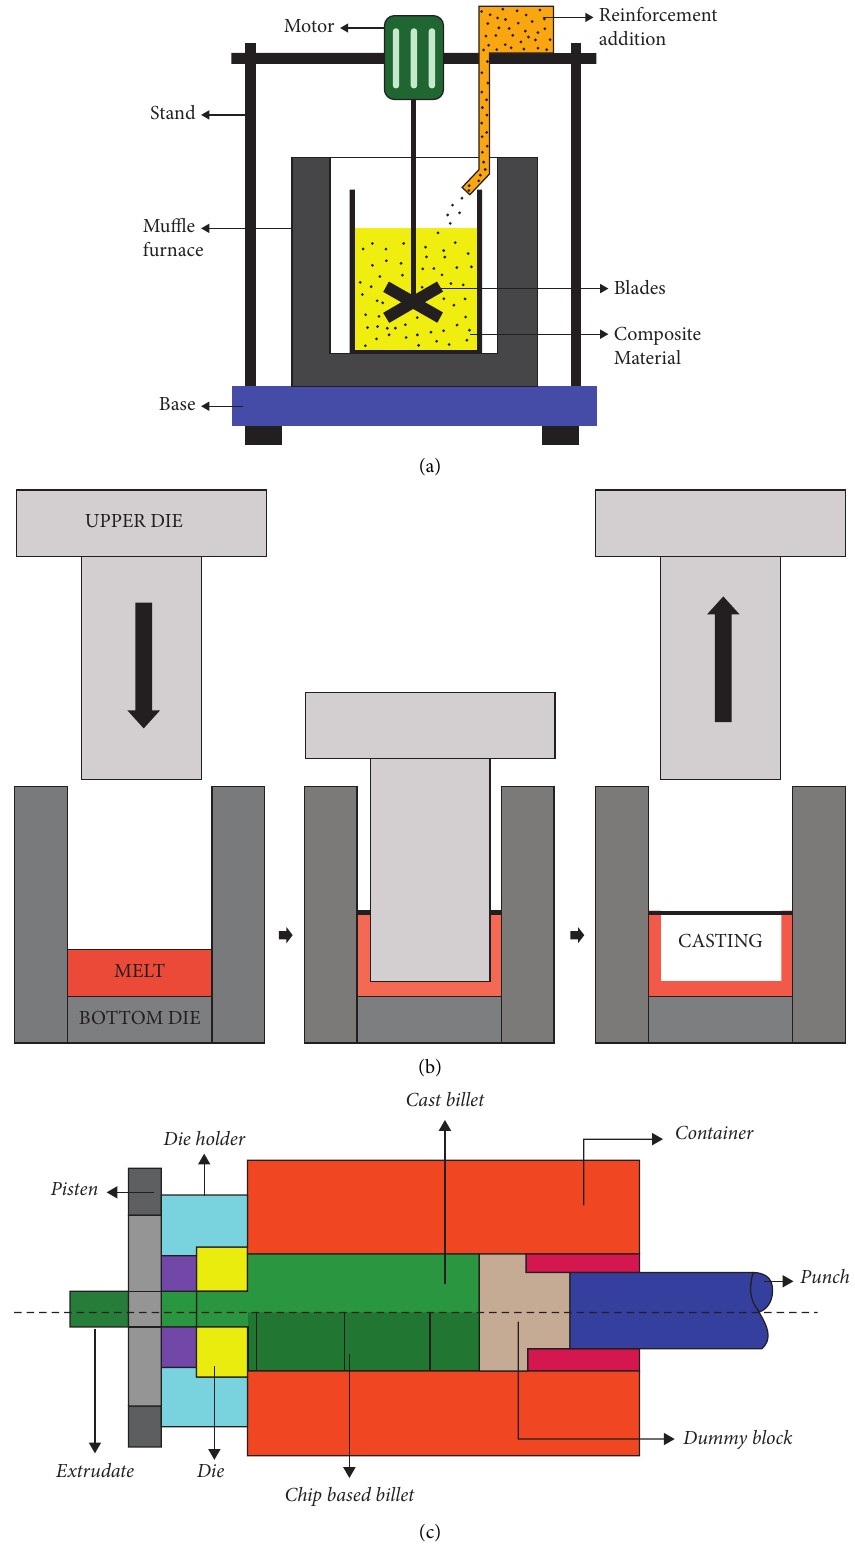
Figure 4: Schematic diagram of fabrication process: (a) stir casting, (b) powder metallurgy, and (c) hot